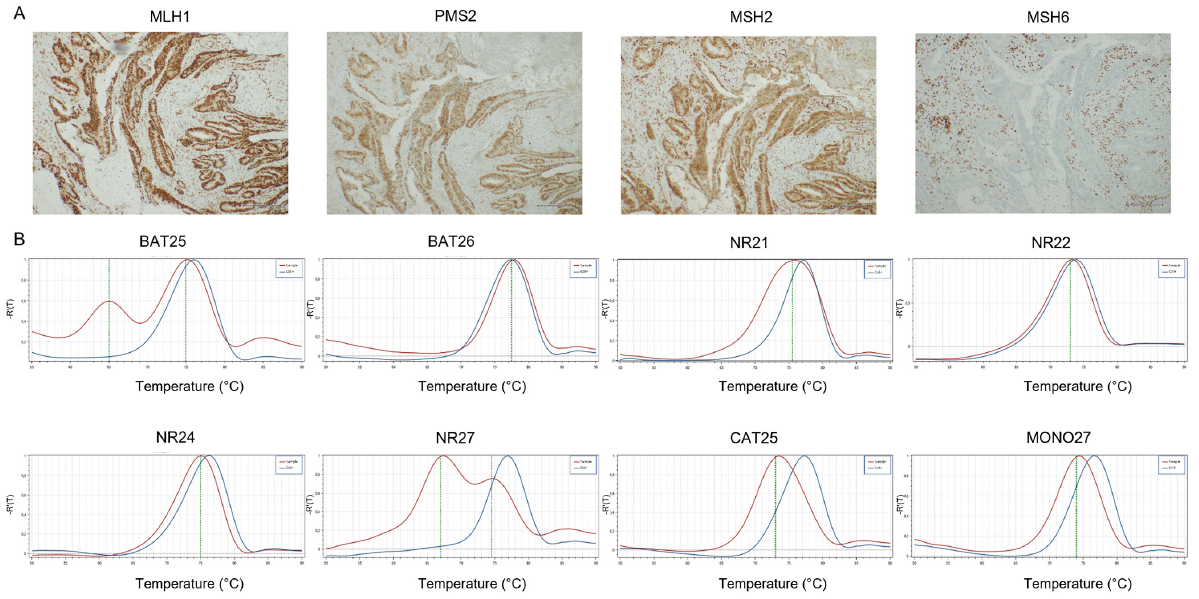
Figure 2. Representative results of CRC case showing dMMR-IHC and MSI-H by PCR. ( A ) MMR- IHC results: intact expression of MLH1 and PMS2 in tumor cells (original magnification 10×); loss of expression of MSH2 and MSH6 in tumor cells with positive internal control (original magnification 10×). ( B ) MSI-PCR results: stability of NR21, NR22 and MONO27; instability of BAT25, BAT26, NR21, NR24, NR27 and CAT25 (red lines indicate samples while blue lines indicate MSS controls).